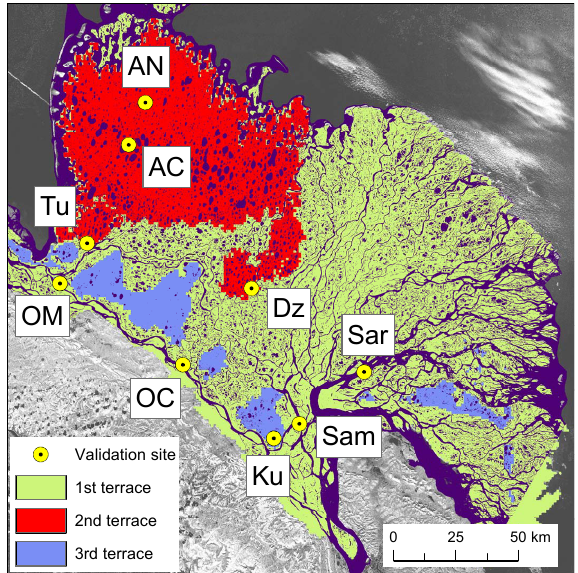
Figure 1. The Lena River delta with the three stratigraphic classes distinguished in the ground thermal modeling (Sect. 3.2) and sites with in situ observations (Sect. 2.2.2) employed for model